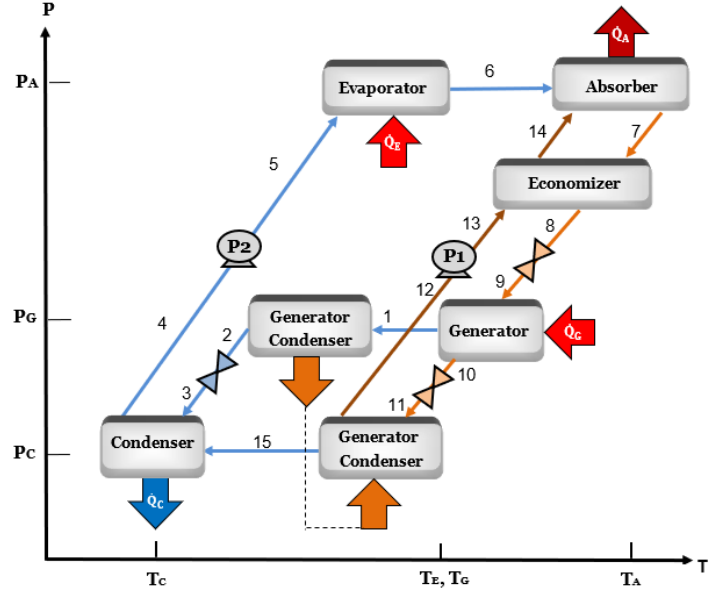
Figure 2. Temperature and pressure levels of a double-effect heat transformer (DEHT).